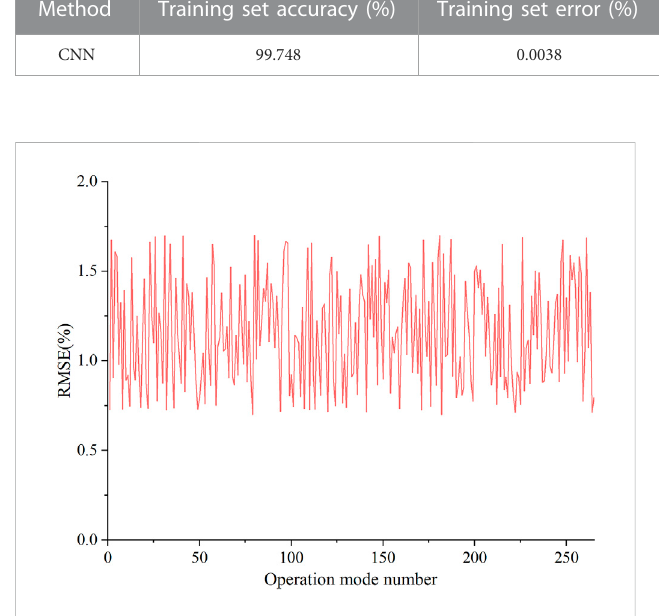
RMSE of the equivalent parameter estimation model based on